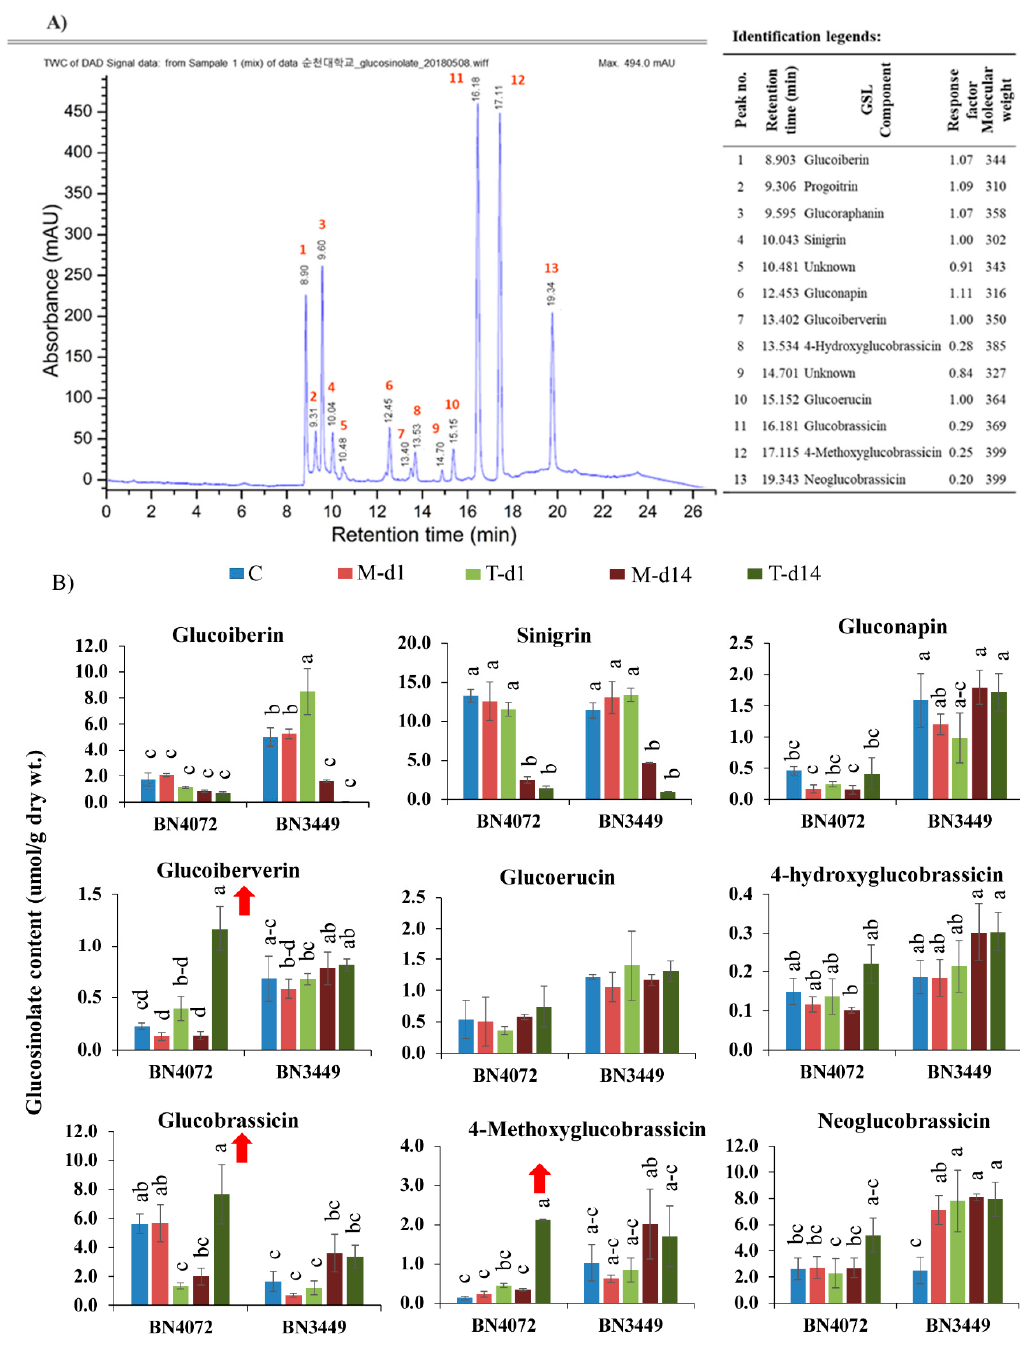
Figure 2. ( A ) A sample illustrative spectrum obtained from mass spectrometry analysis (HPLC/MS, Agilent 1200 series, Agilent Technologies) to identify individual GSLs of cabbage leaf extracts. Tentative determination of peaks, Retention time (min), Response factors were performed as indicated in the identification legends. ( B ) Individual glucosinolate contents of leaf samples from ringspot R line BN4072 and S line BN3449 of cabbage under different treatments (C: Control; M-d1: Mock day 1; T-d1: Treated day 1; M-d14: Mock day 14; T-d14: Treated day 14). The means of three biological replicates are shown. Vertical bars indicate standard deviation. Different letters indicate statistically significant differences between R and S lines, and treatment interactions. Upward-pointing red arrows indicate increased glucosinolate content in response to Mycosphaerella brassicicola infection. R: Resistant; S: